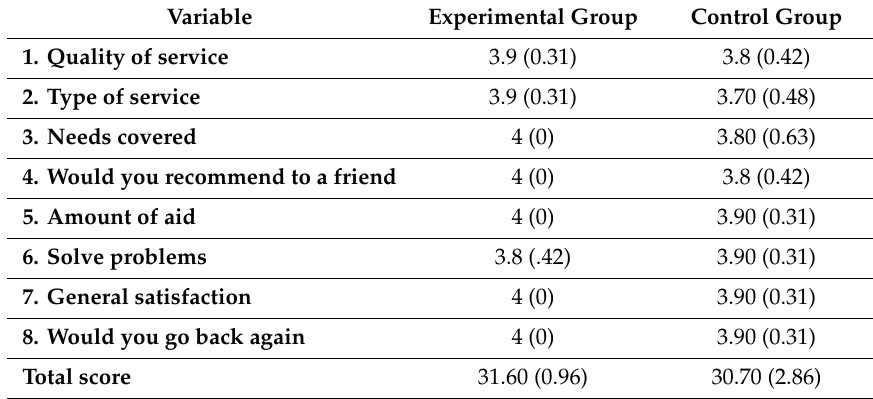
Table 5. Degree of satisfaction with the treatment client satisfaction